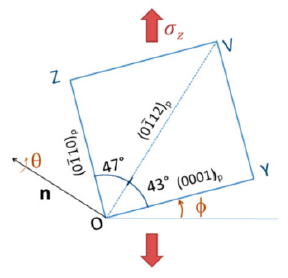
Figure 13. Scheme of loading, which is used for study of inclination from Schmid law in [87]. The definition of angles θ and φ is illustrated. OZVY is the projection of hcp unit cell along < a > hcp direction (Reproduced from [87], with permission from Elsevier, 2017).